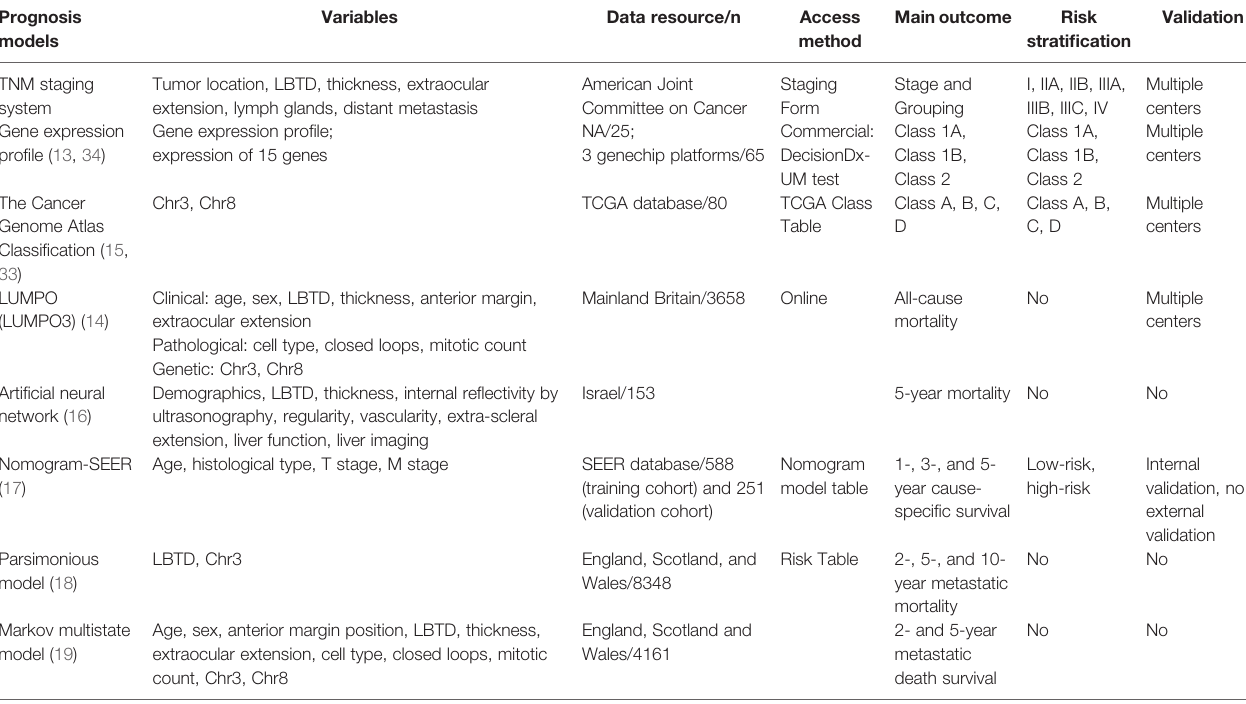
TABLE 4 | Prognostic prediction models for uveal melanoma. Prognosis